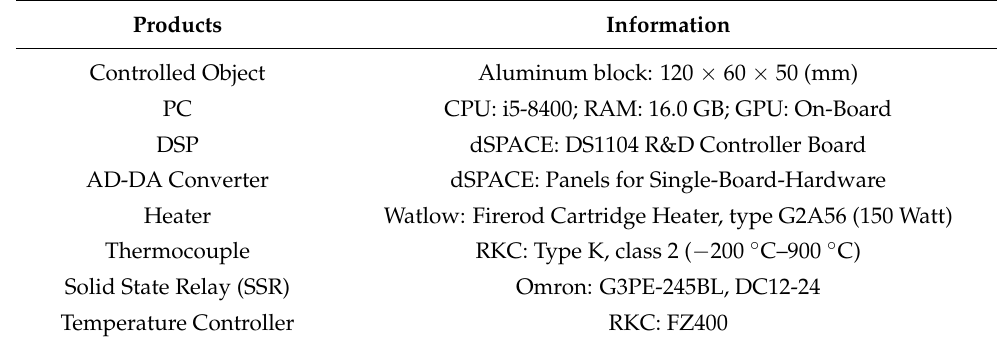
Figure 3. Experimental setup of the temperature control system. Table 1. Experimental equipment information of our temperature control